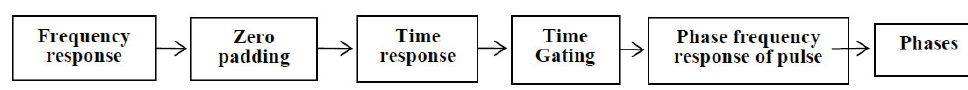
Figure 6. Phase calculation process through vector network analyzer